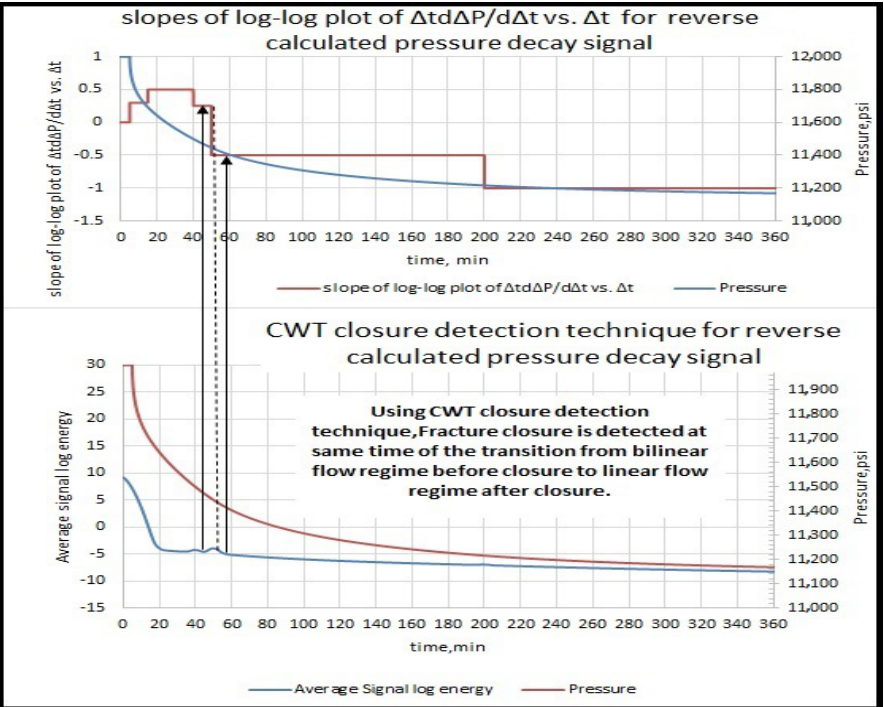
Figure 19. Closure pressure detection using the CWT technique for the synthetic reverse-calculated pressure decay